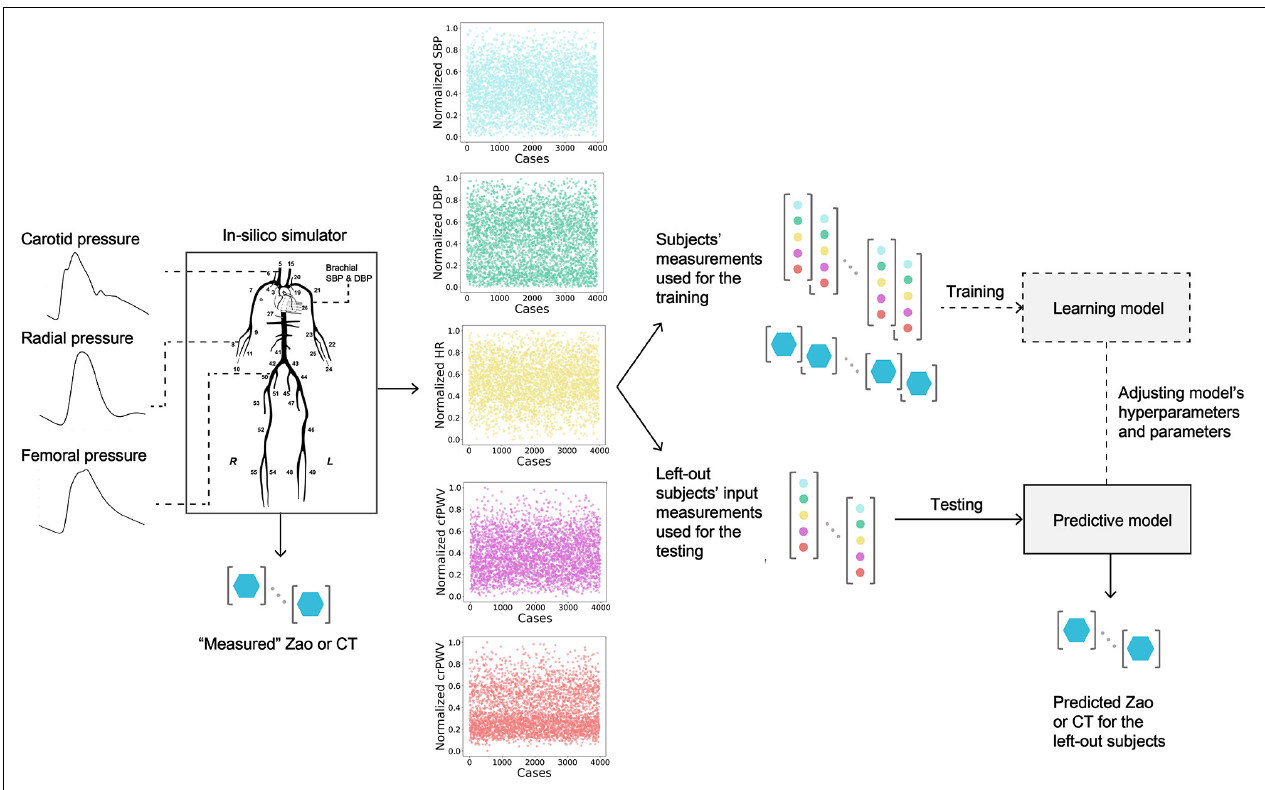
FIGURE 1 | Schematic representation of the training/testing pipeline for predicting aortic characteristic impedance (Z ao ), and total arterial compliance (C T ). SBP, systolic blood pressure; DBP, diastolic blood pressure; HR, heart rate; cfPWV, carotid-femoral pulse wave velocity; crPWV, carotid-radial pulse wave velocity.